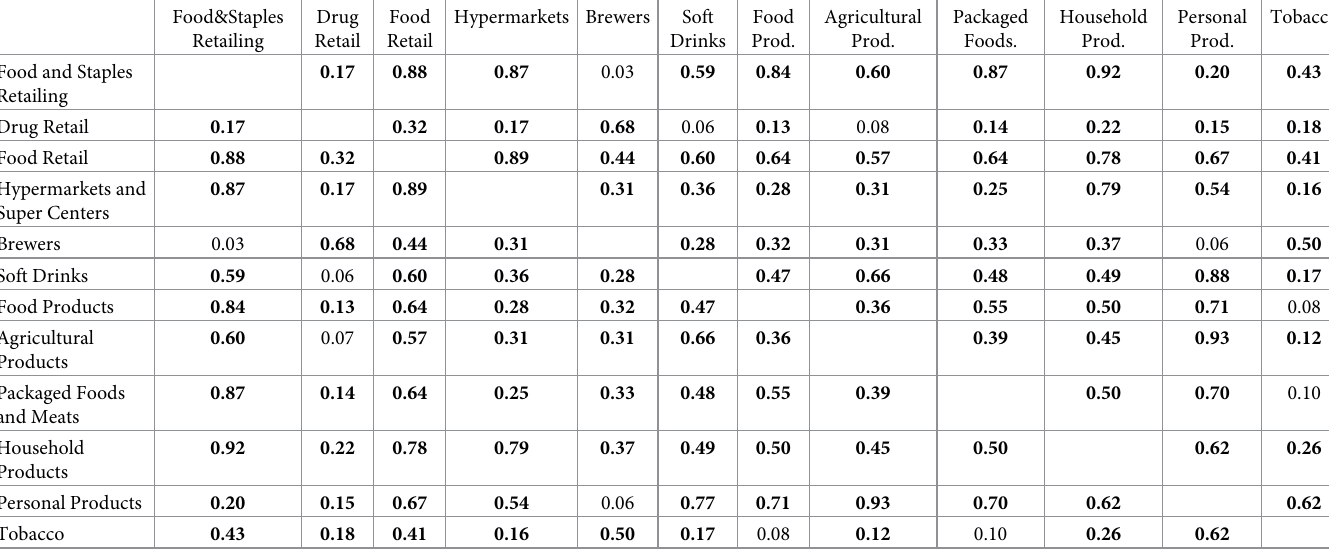
Table 10. Consumer staples industry.